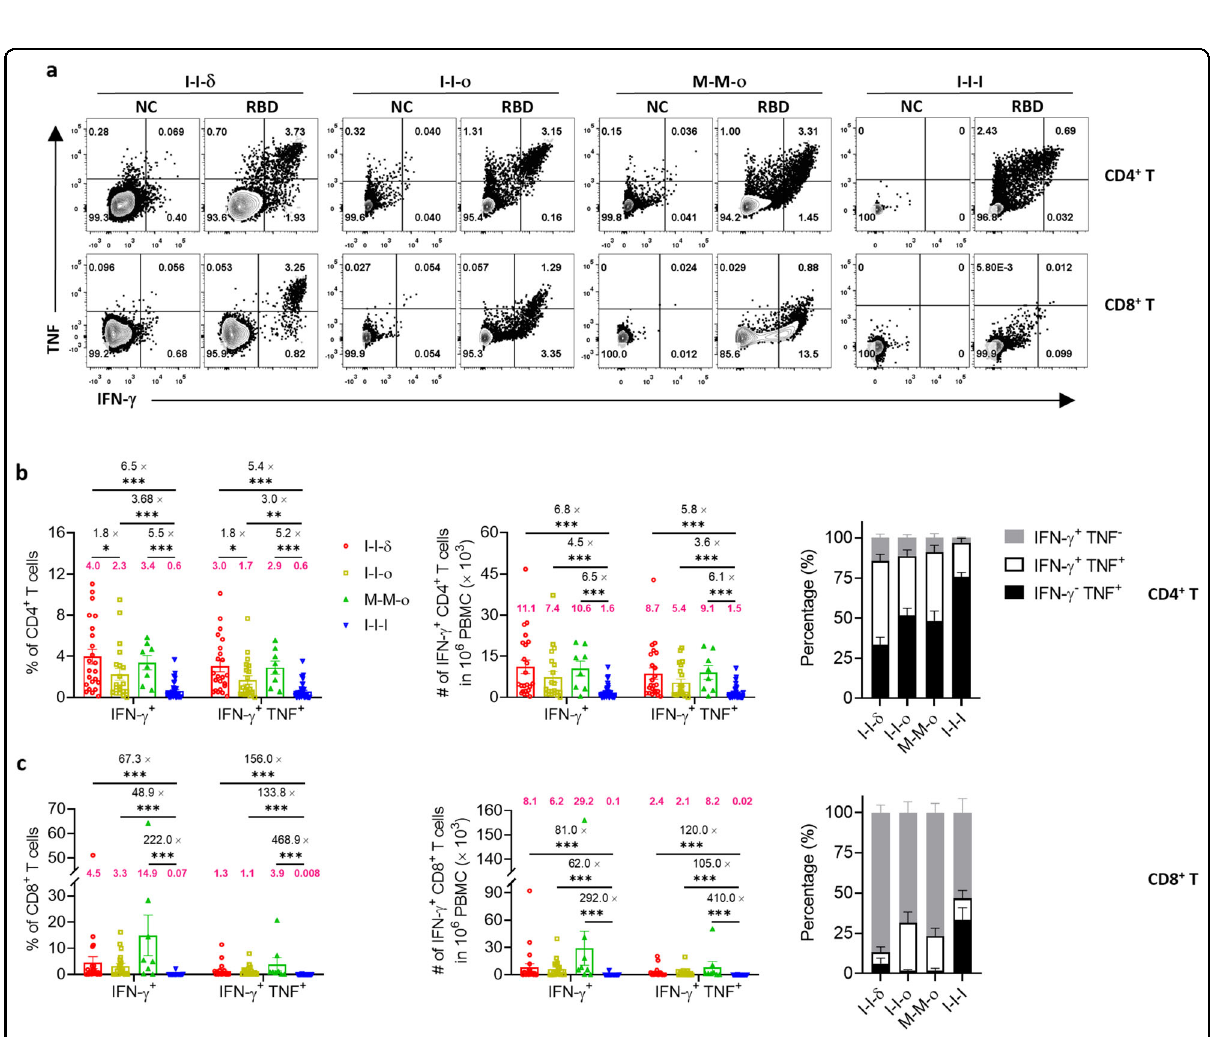
Fig. 4 RBD-speci fi c T-cell responses against WT SARS-CoV-2 in vitro. a Representative fl ow cytometry plots in the I-I- δ , I-I- ο , M-M- ο , and I-I-I groups showing RBD-speci fi c CD4 + and CD8 + T-cell responses against WT RBD peptide pool. b , c Frequency and numbers of all RBD-speci fi c CD4 + and CD8 + T cells in the I-I- δ ( n = 23), I-I- ο ( n = 21), M-M- ο ( n = 8), and I-I-I ( n = 40) groups. The number in magenta indicates the mean in the frequency and numbers of detected responses. Each dot represents one donor. Comparisons were performed using Mann – Whitney tests. * P < 0.05, ** P < 0.01, *** P <